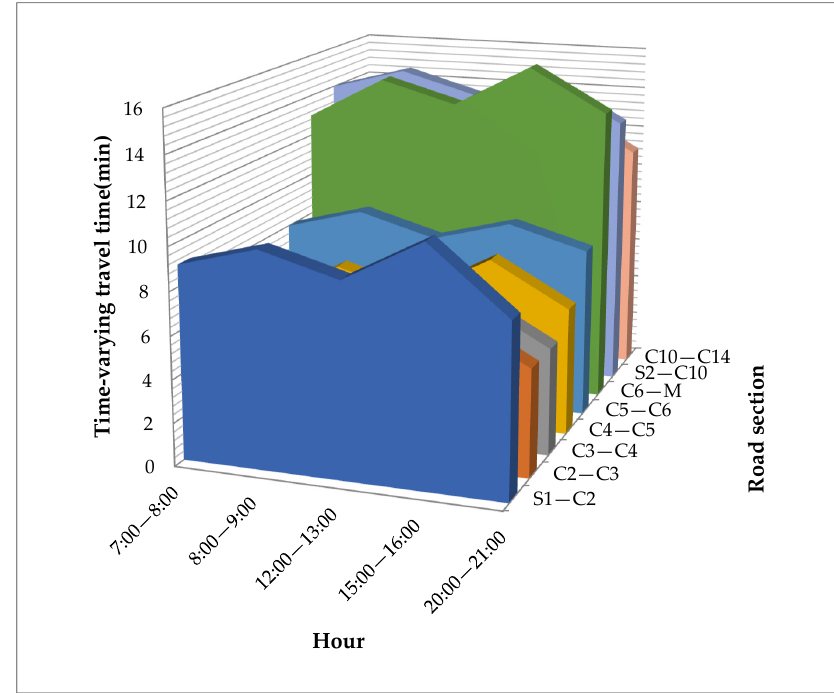
Figure 5. Time ‐ varying travel time of some road sections in five periods. Table 3. Data on all demand points.